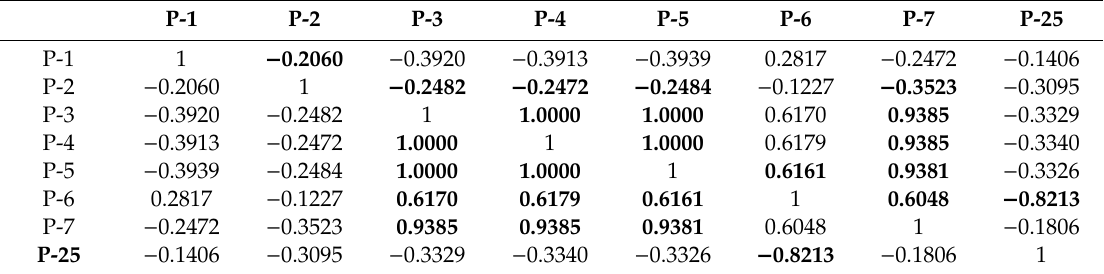
Table 2. Correlation between the quality indicators and limit of attenuation (LAT) for the test wheat (Pearson correlation